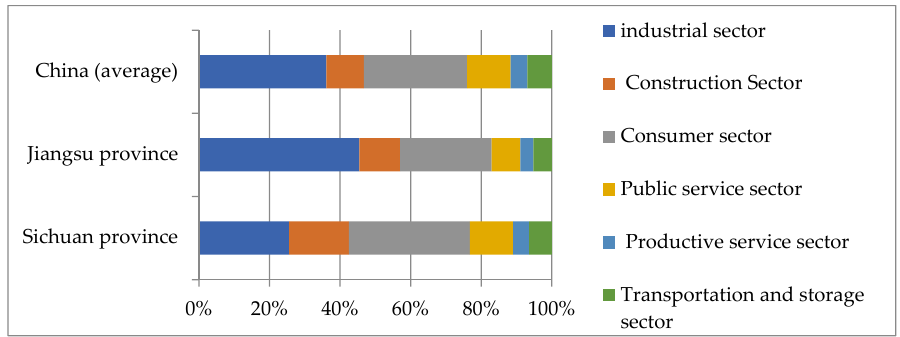
Figure 6. Comparative analysis of sub-sector structure of non-agricultural employment in Sichuan (data sources are Sichuan Statistical Yearbook 2020 , Jiangsu Statistical Yearbook 2020 , and China Statistical Yearbook 2020 ).